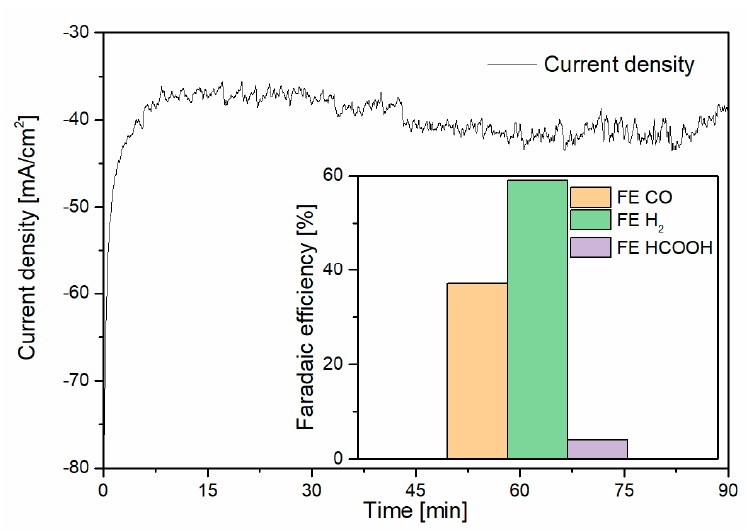
Figure 9. Conversion module results with an initial 16%/84% gas stream; average current density during the measure and (inset) faradaic efficiencies of the reaction products (FE = faradaic effi- ciency) .